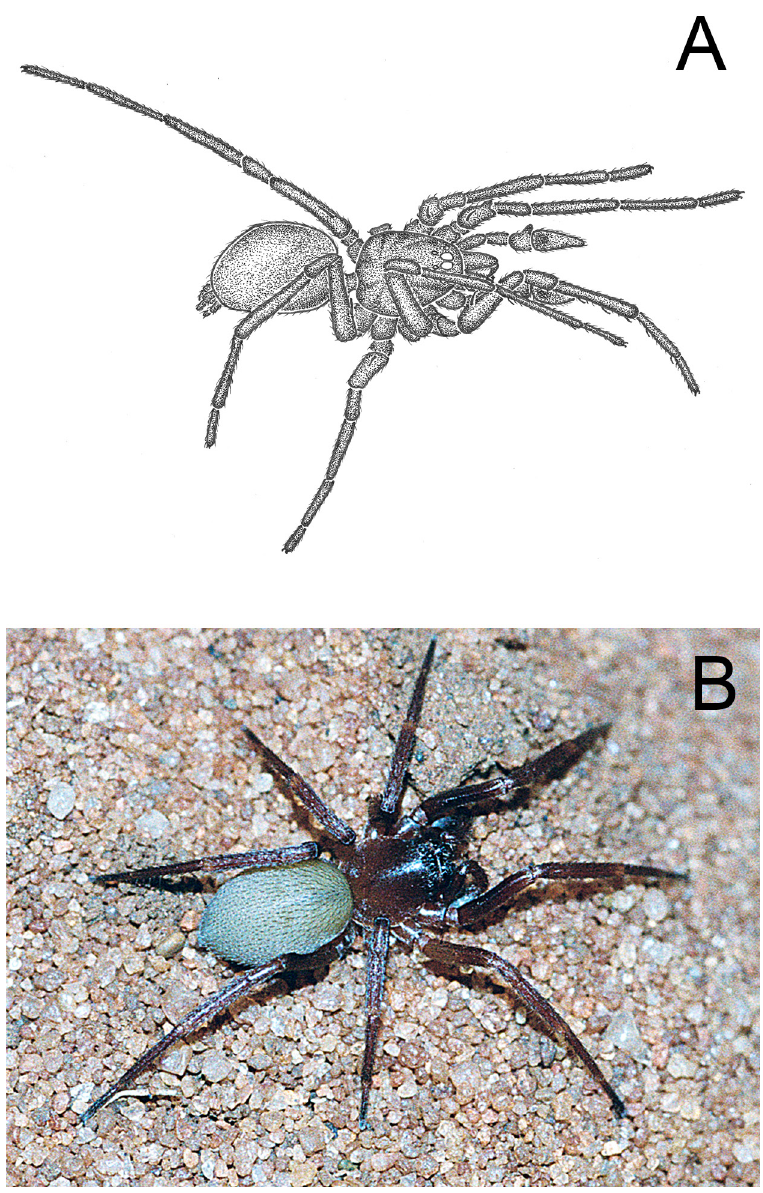
Fig. 1. A . Impression of the habitus of a living male of Andromma anochetorum Simon, 1909. B . Live female specimen of Andromma raffrayi Simon, 1899, photo © C.G-Haddad, locality